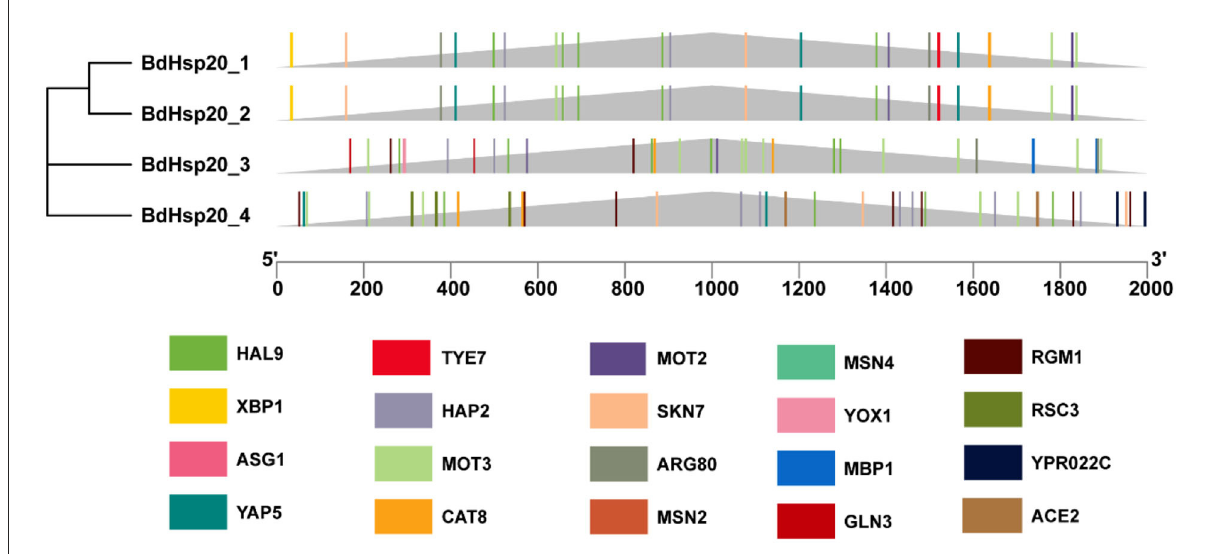
FIGURE6 Schematic diagram of the transcription factor-binding sites of the BdHsp20 gene family predicted by using JASPAR online tool.